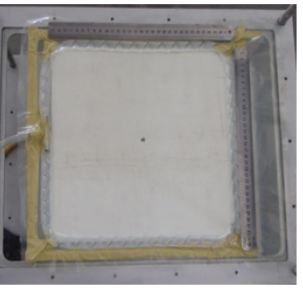
Table 2: Properties of resin system Resin System